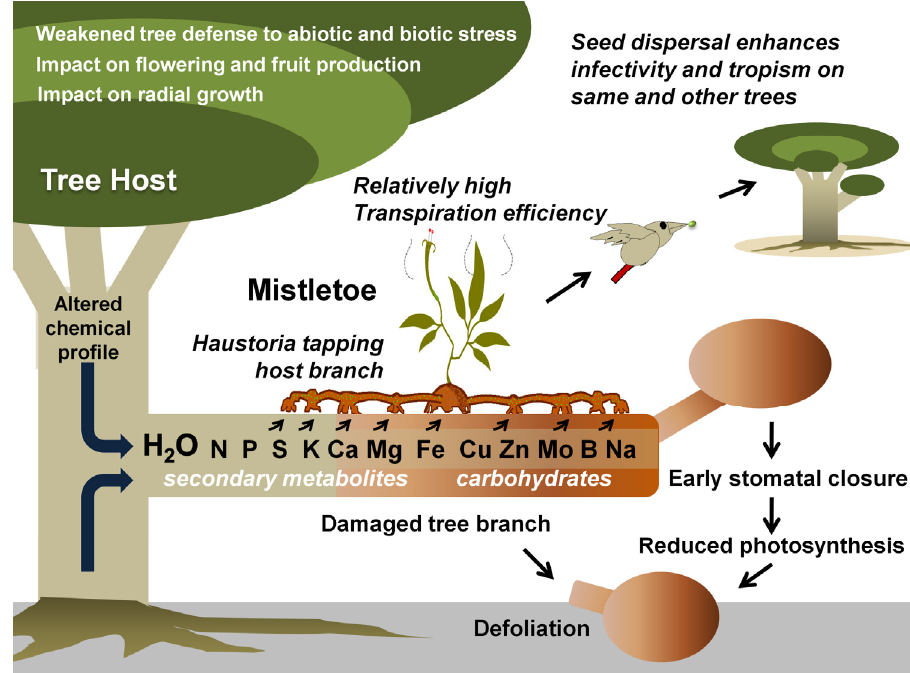
Figure 1. Mistletoe parasitism and impacts on a tree host. Specific mistletoe may parasitize its host by exploiting its branch(es) for water and various other resources, thereby limiting its photosynthetic potential, optimal growth, response to various stresses, and fruit or timber production. Gradually, infective spread (by haustorial connections and endophytic expansion) and growing infection instances (ensured by mistletoe seed dispersal) may lead to early senescence of the tree(s).